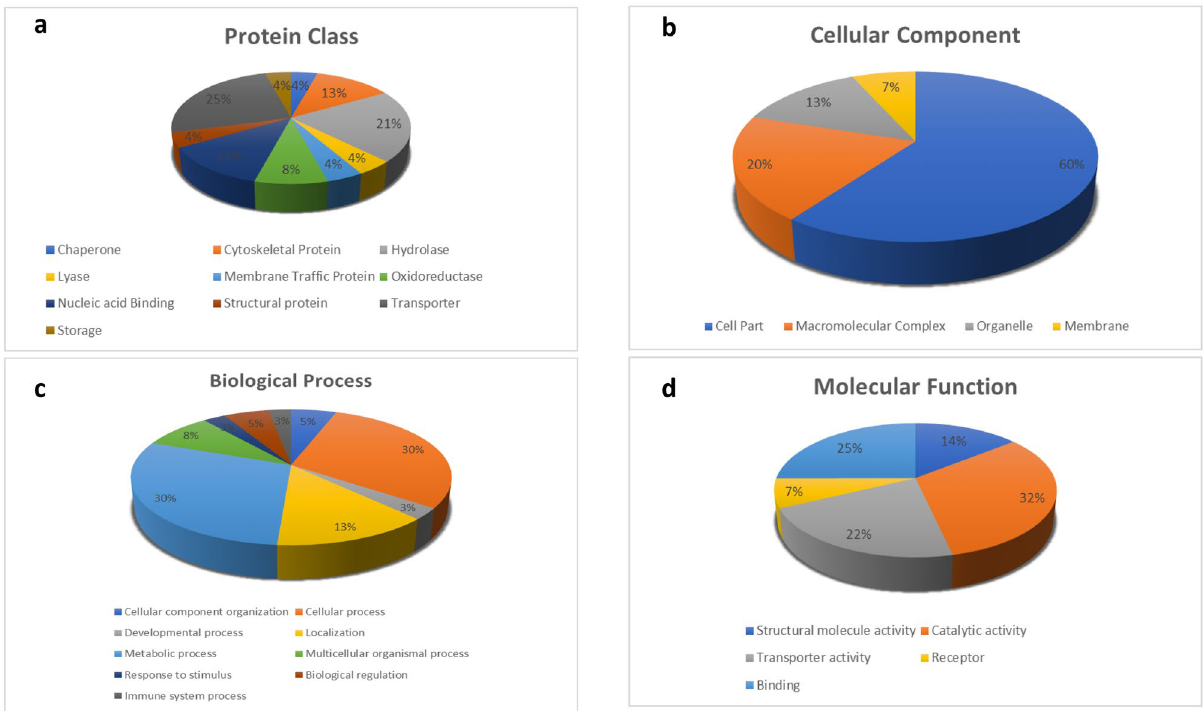
Figure 4. Functional classification of differentially expressed protein components of the 13 protein complexes in the prefrontal cortex of Alzheimer’s disease brain. The nano LC–MS/MS identified cortical proteins were characterized within the molecular function gene ontology (GO) category. Subcellular and functional categories were based on the annotations of GO using the online tool at www. panth erdb. org in the following categories ( a ) protein class, ( b ) cellular component, ( c ) biological process and ( d ) molecular function .